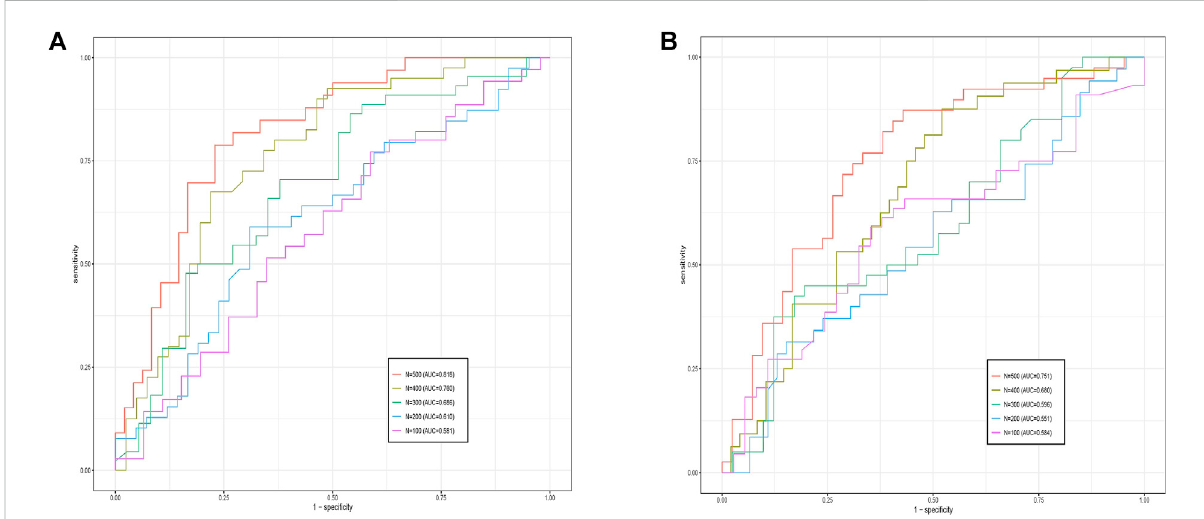
FIGURE 3 Comparative receiver operating characteristics curves of G-EDNN performance for different sample sizes. The left side shows the results for GSE28127,andtherightsideshowstheresultsforGSE95496.ThelegenddepictsthesamplesizeandtheAUCvalueforeachsamplesizeonthedata. As the sample size decreases, corresponding AUC values also